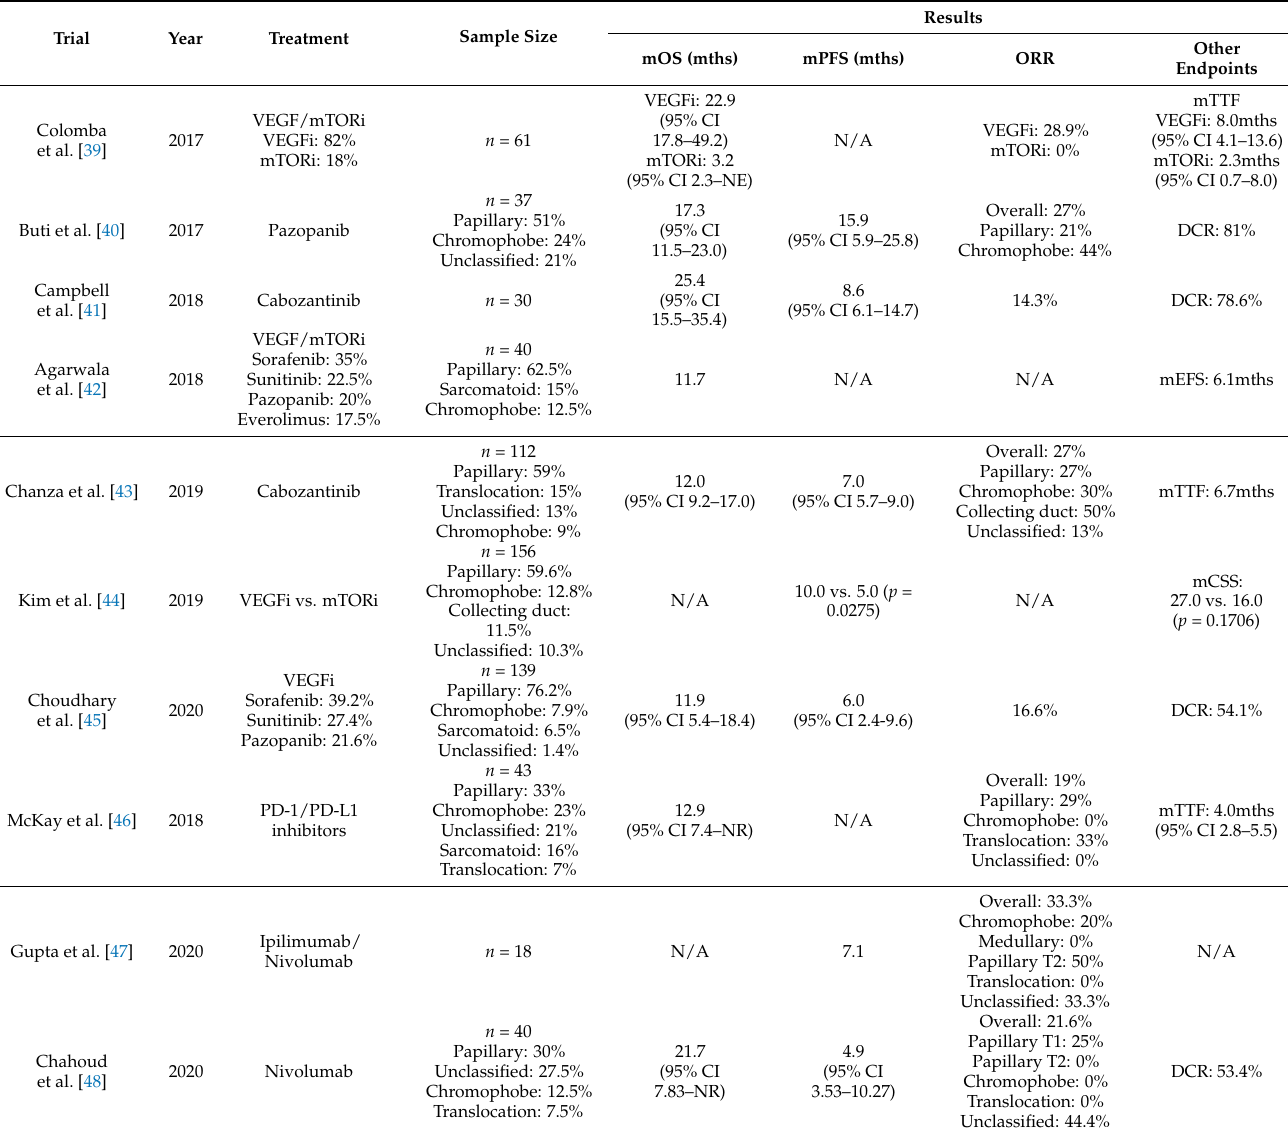
Table 2. Selected retrospective studies of targeted and immunotherapy in nccRCC